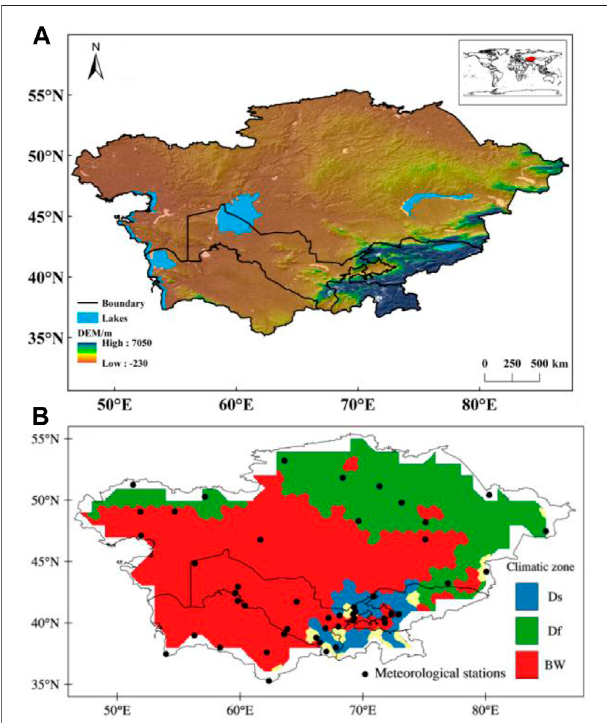
FIGURE 1 | Location of the topography and geographical position (A) , andtheraingaugesindifferentclimaticzones (B) overCA(Dfdomainnorthern of the Kazakhstan (48 ° − 54 ° N, 61 ° − 86 ° E), BW domain southwestern of the Kazakhstan,Uzbekistan,Turkmenistan(35 ° − 48 ° N,54 ° − 68 ° E),Dsmainly distributed in Kyrgyzstan and Tajikistan (37 ° − 43 ° N, 68 ° − 77 °